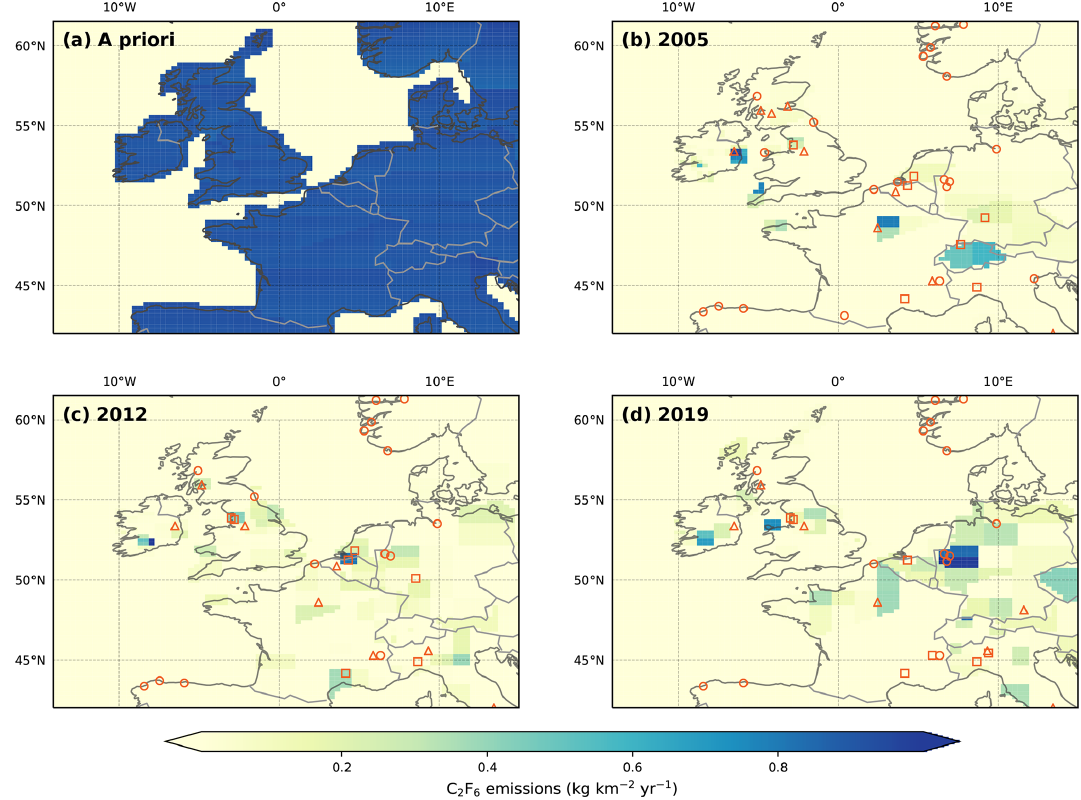
Figure 8. Northwest European C 2 F 6 emissions in kgkm − 2 yr − 1 . (a) The a priori emissions field. With the exception of the oceans, emissions were distributed uniformly across the model domain. A posteriori emissions are shown for (b) 2005, (c) 2012 and (d) 2019. Facilities that reported PFC emissions to the E-PRTR in the selected year are shown as orange circles (aluminium smelters), triangles (electronics manufacturers) and squares (chemical manufacturers, including petroleum products). Since the reporting period for the E-PRTR is shorter than that of our measurements, 2005 and 2019 emissions are compared to the earliest (2007) and latest (2017) years of the E-PRTR database, respectively. Note that the E-PRTR database reports cumulative PFC